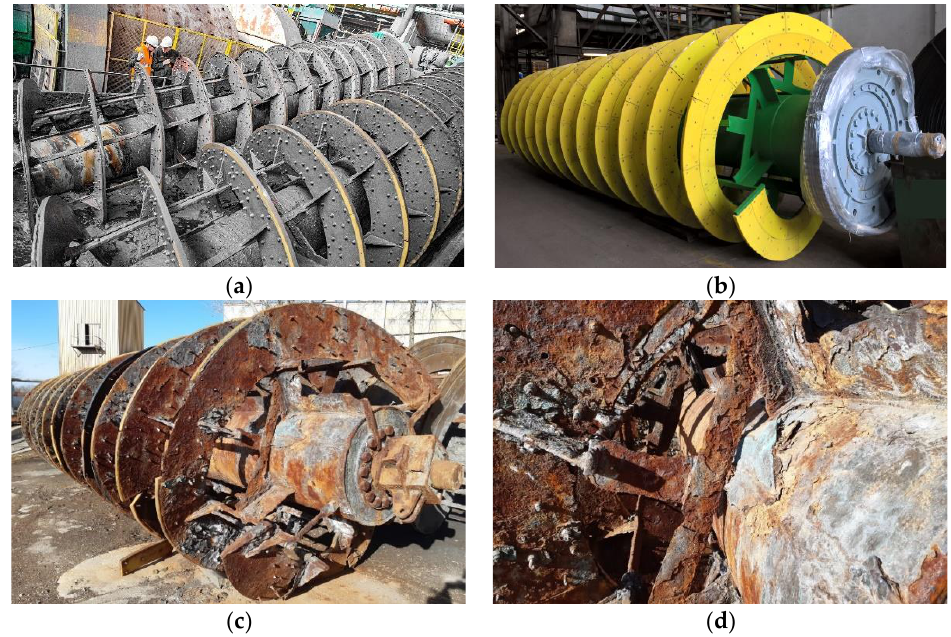
Figure 1. View of an operating classifier ( a ), and a new ( b ) and used ( c , d ) spiral.